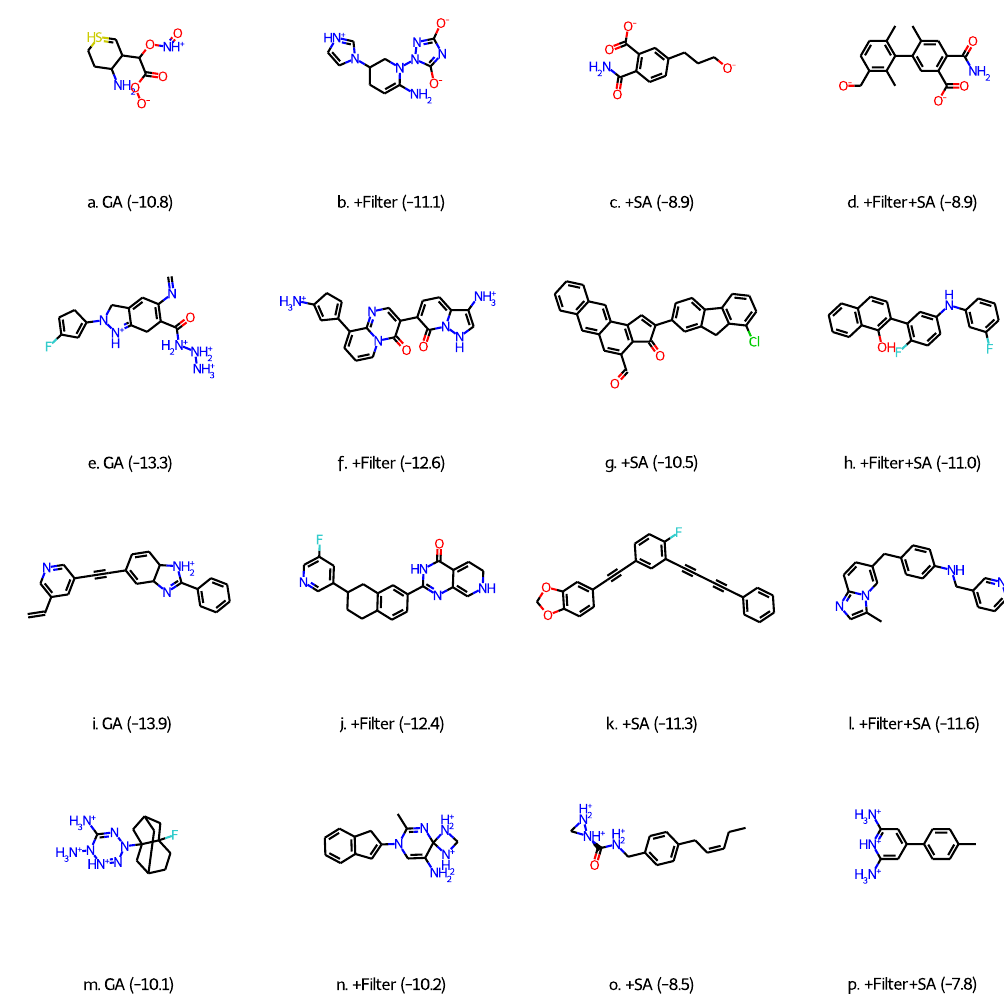
Figure 1 Best scoring molecules from the final population of GA-docking runs (see text for explana- tion) for the four different targets: CM (A–D), β 2 AR (E–H), DDR1 (I–L), and BCD (M–P). The scores (in kcal/mol) are shown in parentheses. Full-size DOI: